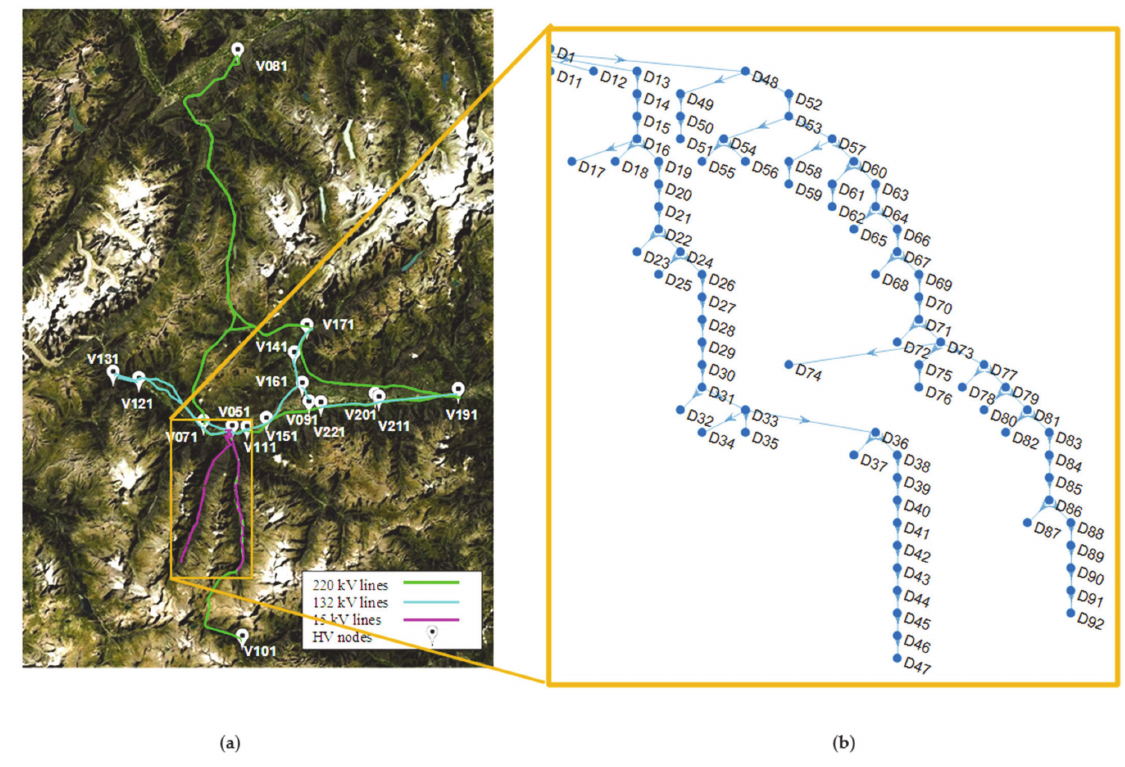
Figure 2. Integrated MV/HV/EHV grid: ( a ) map of the MV feeders and of the surrounding HV grid, ( b ) one-line diagram of the two feeders.